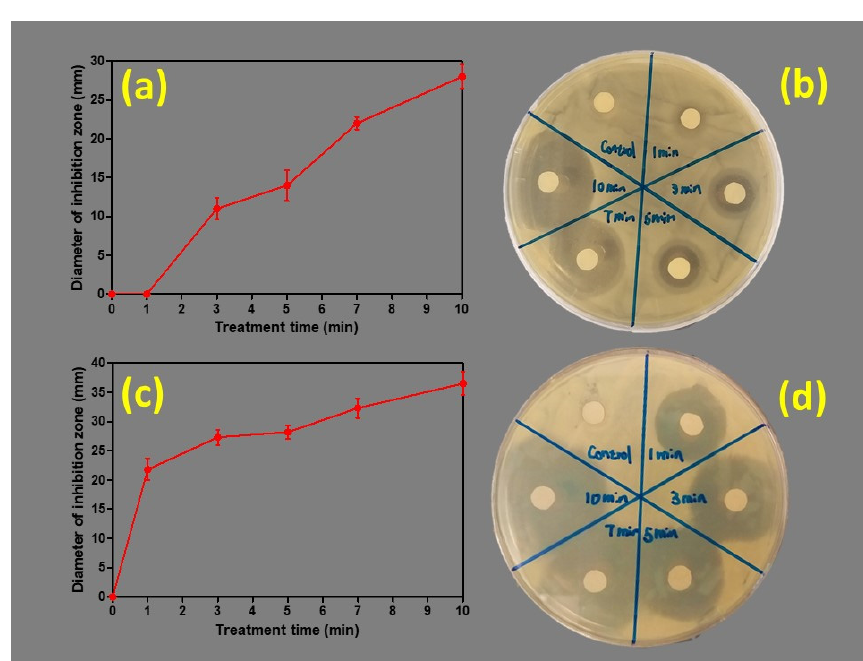
Figure 4. Treatment (plasma exposure time) time curves for ( a ) E. coli and ( c ) S. aureus. Example optical image of E. coli clearance zones ( b ) and S. aureus ( d ) on agar plates with different silver nanoparticle samples under visible light .